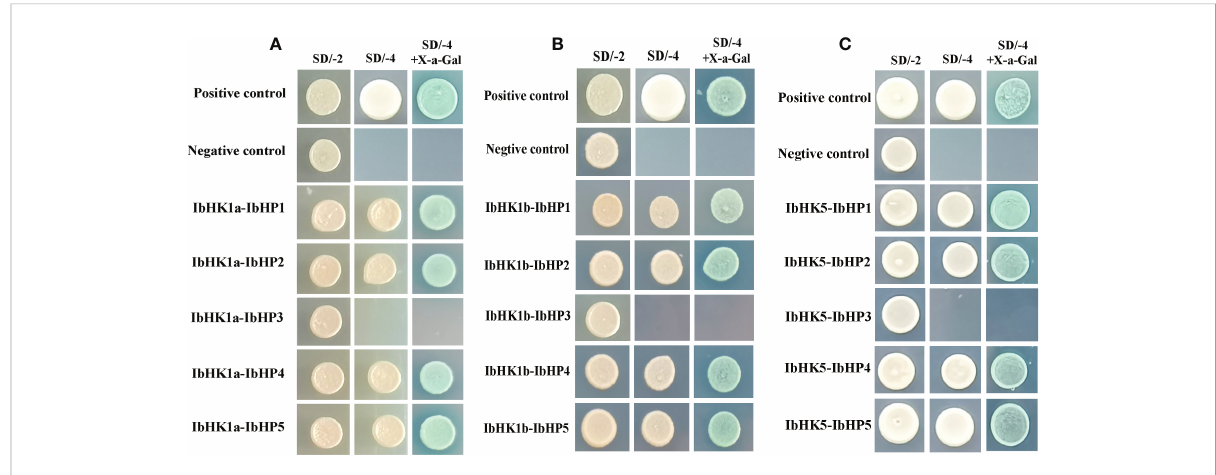
FIGURE 8 Protein-protein interaction studies among IbHKs and IbHP1~IbHP5 with yeast-two hybrid assays. (A) Interactions between IbHK1a and IbHP1~IbHP5, (B) Interactions between IbHK1b and IbHP1~IbHP5, (C) Interactions between IbHK5 and